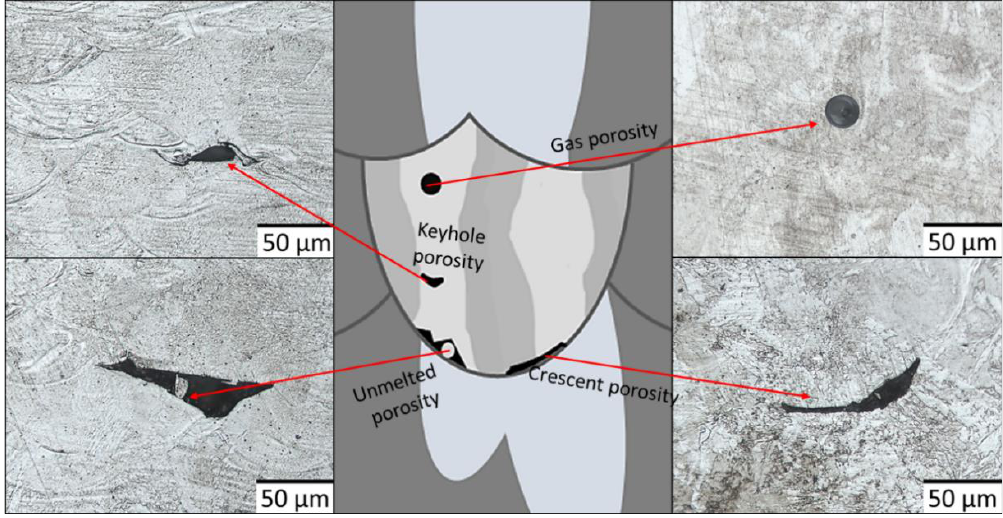
Figure 16. Schematic diagram of 14-7 microstructure produced by SLM method.